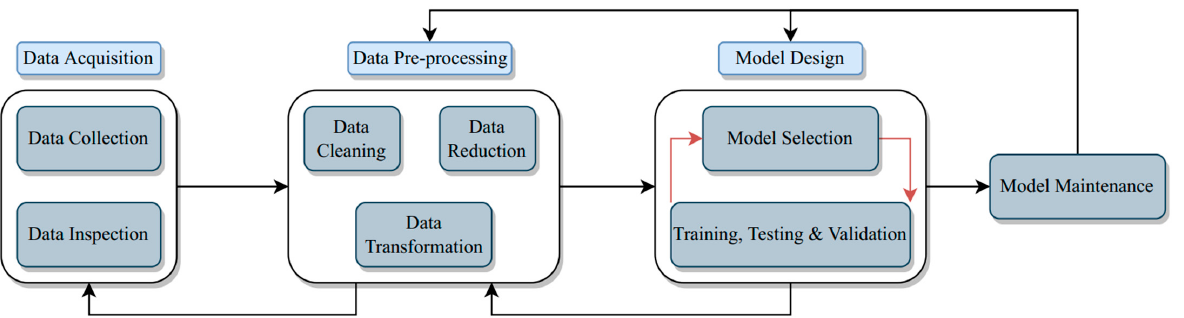
Figure 3. An overview of virtual sensing development steps